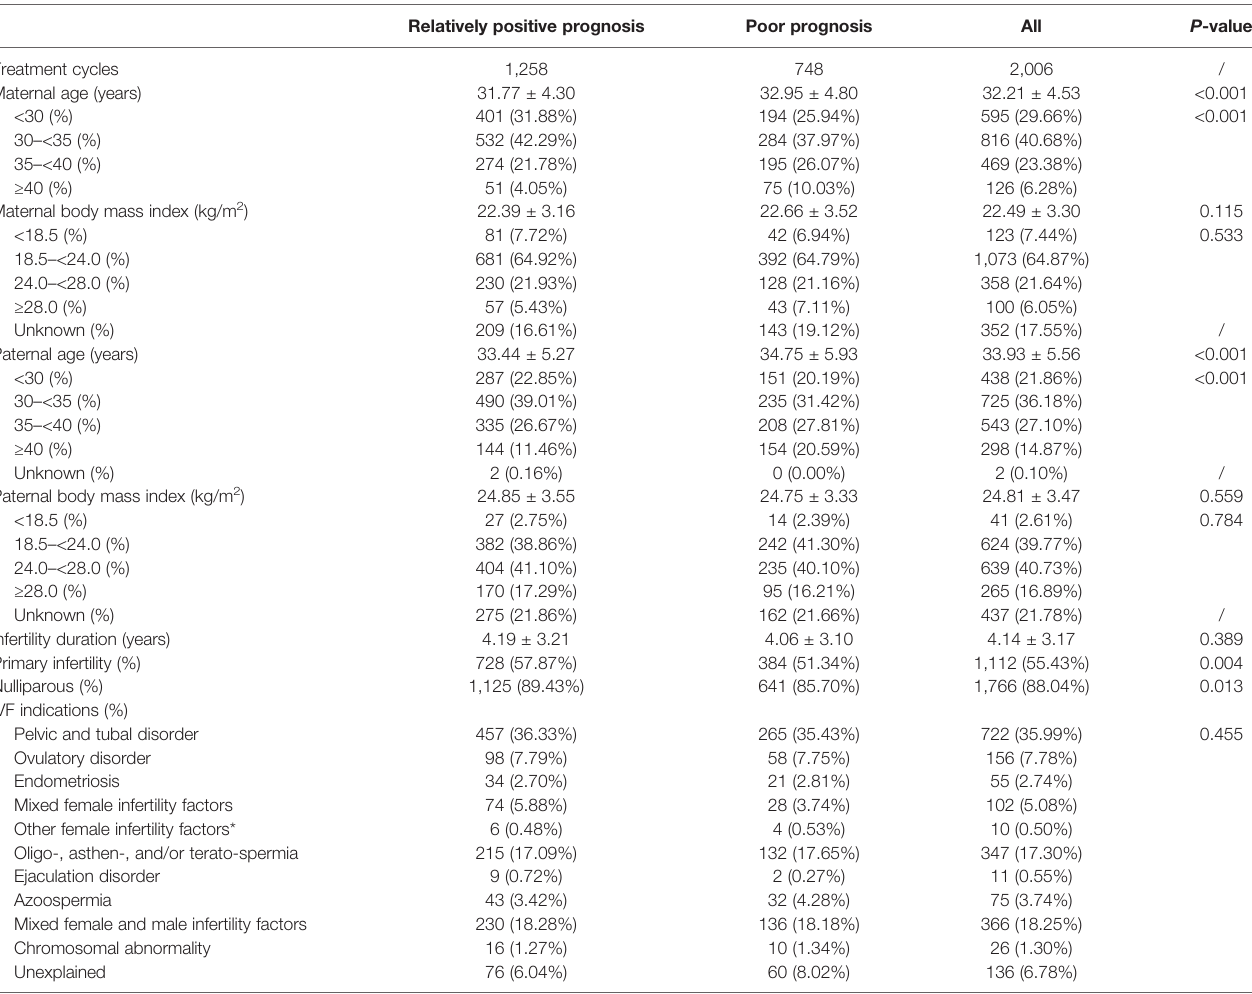
TABLE 2 | Basal characteristics of patients with congenital anomalies after in vitro